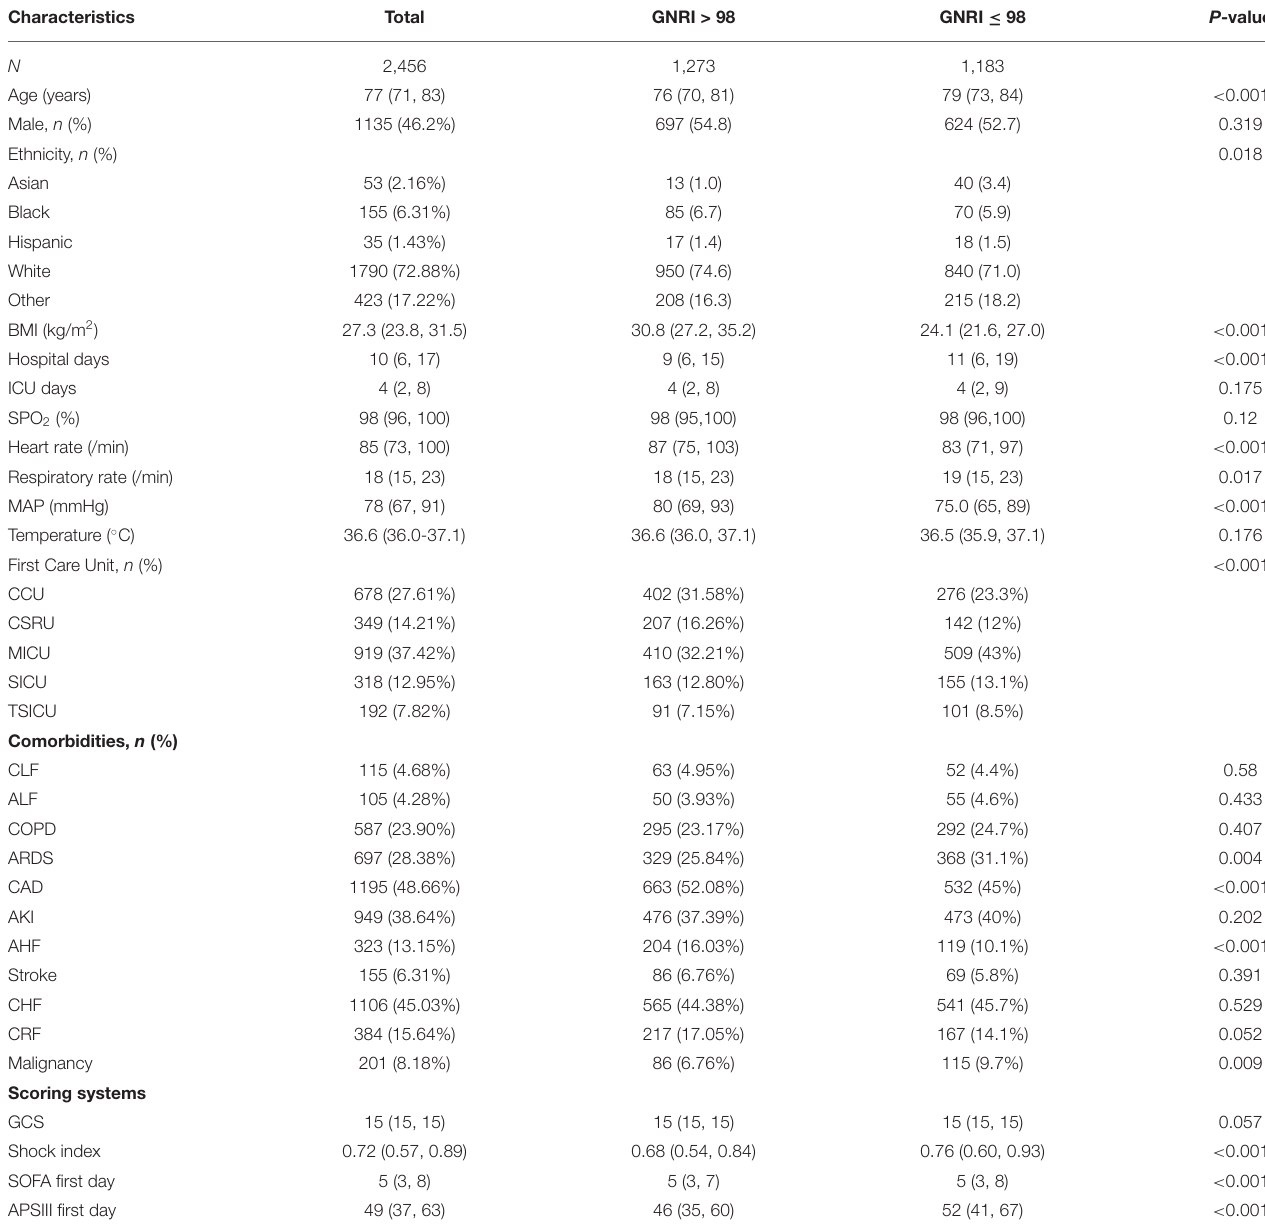
TABLE 1 | Characteristics of patients in the normal nutrition and malnutrition groups.